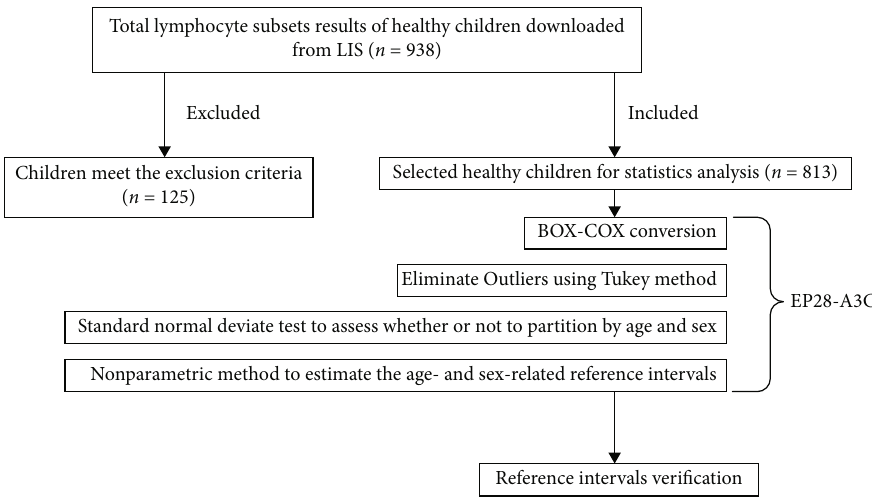
Figure 1: The fl ow chart of this study for establishing reference values. Table 1: The lymphocyte subset reference interval calculated by nonparametric